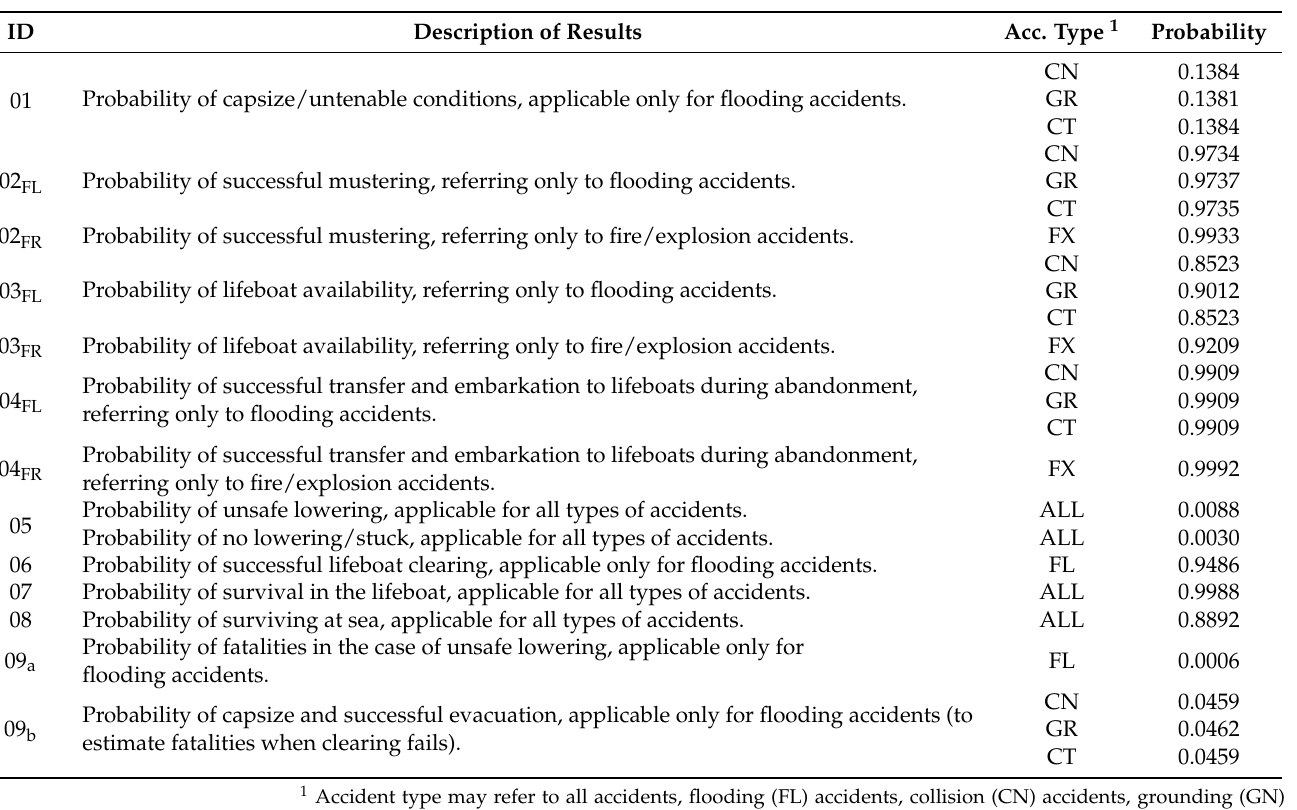
Table 3. GeNIe results for all Bayesian networks and accident